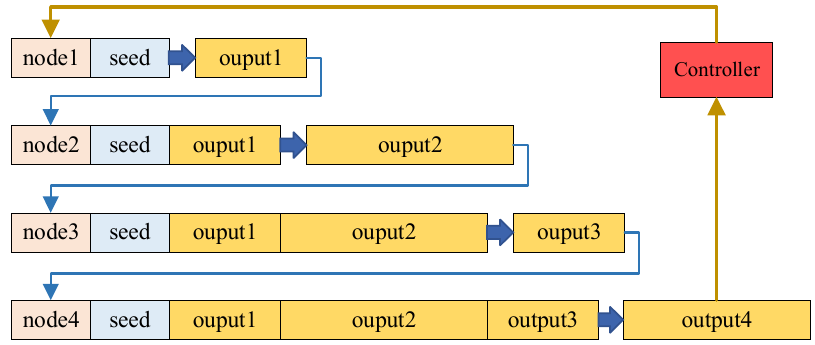
Figure 7. Distributed deployment of an RNN in AIBot.